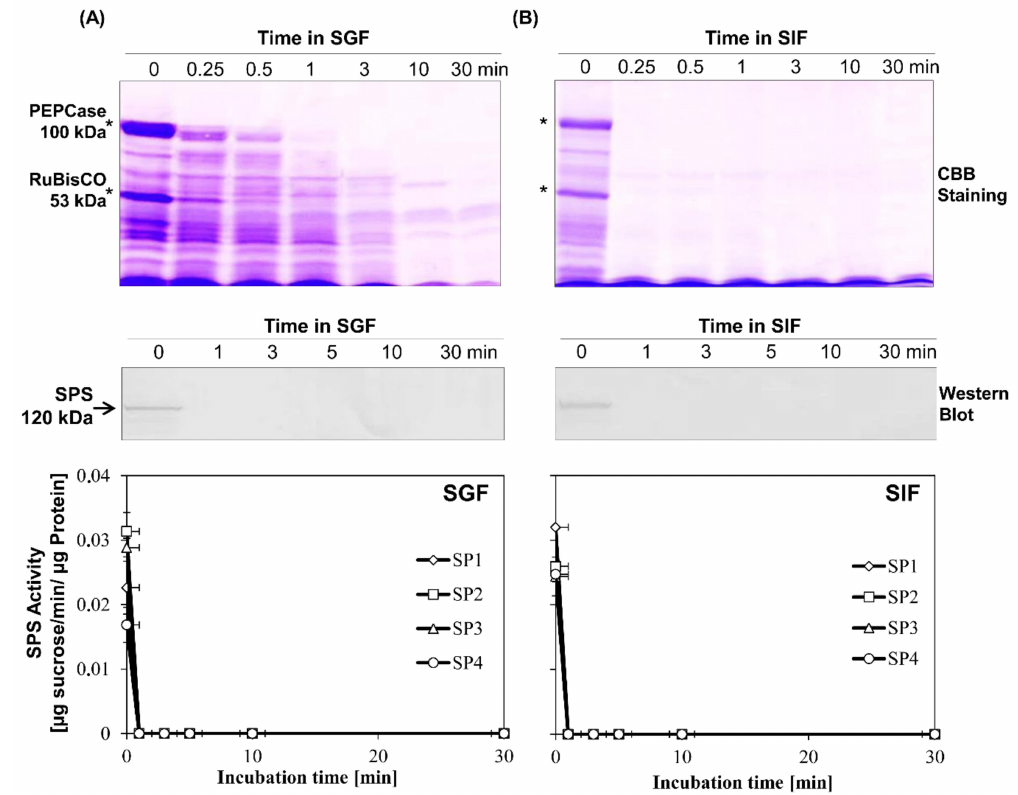
Figure 2. In vitro simulated gastric fluids (SGF) and simulated intestine fluid (SIF) digestion assays of SPS protein. The extracted protein from transgenic sugarcane was digested by pepsin in SGF ( A ) and trypsin in SIF ( B ). The profile of protein after digestive treatment at indicated times were analyzed by SDS-PAGE, followed by staining with Coomassie Brilliant Blue (upper) and subjected to Western blotting using a polyclonal antibody against SPS (middle). The activity of SPS was measured in the extracted protein at incubation times of 0, 1, 3, 5, 10, and 30 min after digestion (lower). Upper and lower asterik represent PEPCase and RubisCO protein bands, respectively. Arrow represents SPS protein